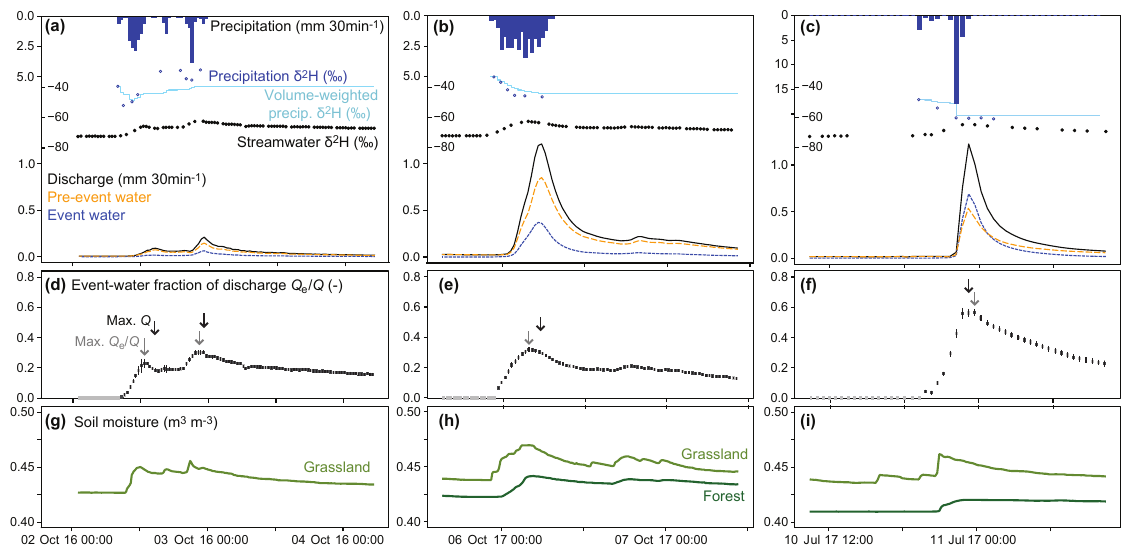
Figure 6. Time series of the storm events of 2 October 2016, 5 October and 10 July 2017. (a–c) precipitation hyetographs and deuterium abundance ( δ 2 H) in precipitation (with individual measurements in dark blue and incremental weighted means in light blue), and stream water (black) as well as discharge hydrograph separated into event and pre-event water. (d–f) event-water fraction of discharge; error bars indicate ± 1SE, and open bars indicate linearly interpolated event-water fractions when discharge isotope measurements are missing. (g– i) soil moisture at the grassland site (light green) and forest site (dark green, no data in 2016). Despite great differences in total event rainfall and antecedent wetness conditions between the two storms in the two left columns, their event-water fractions of discharge are very similar. In most cases, peaks in instantaneous event-water fractions precede peak flows (times of peak values indicated by grey and black vertical arrows in panels (a) to (f)